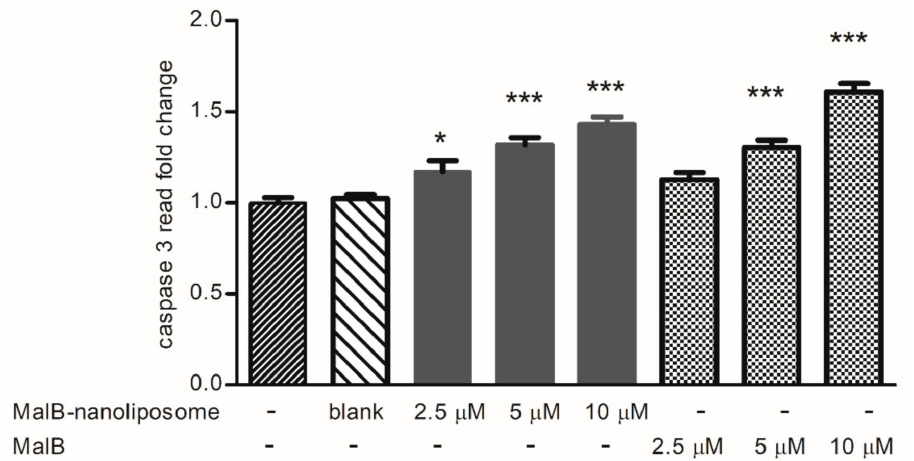
Figure 4. Caspase 3 inducible e ff ects of unconjugated malB and malB-nanoliposomes at di ff erent treated concentrations ranging from 2.5 to 10 µ M on the A549 cells after 24 h of incubation. Normal saline served as the negative control. Each value represents the mean ± SEM. *** p < 0.001 and * p < 0.05 compared to negative